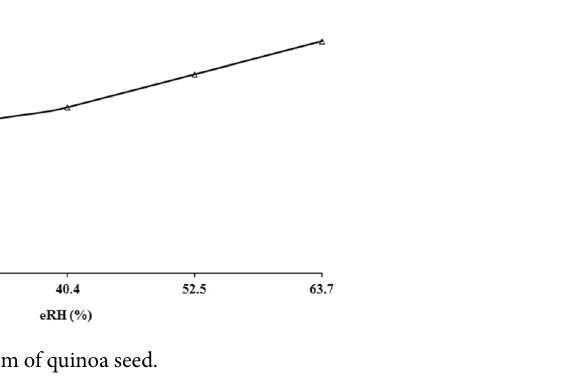
Figure 9. Moisture isotherm of quinoa